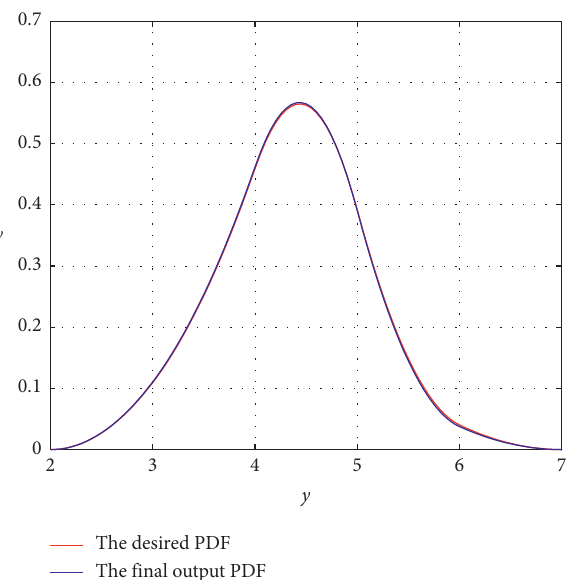
Figure 13: The expected output PDF and the final output PDF with the proposed FTTC strategy.